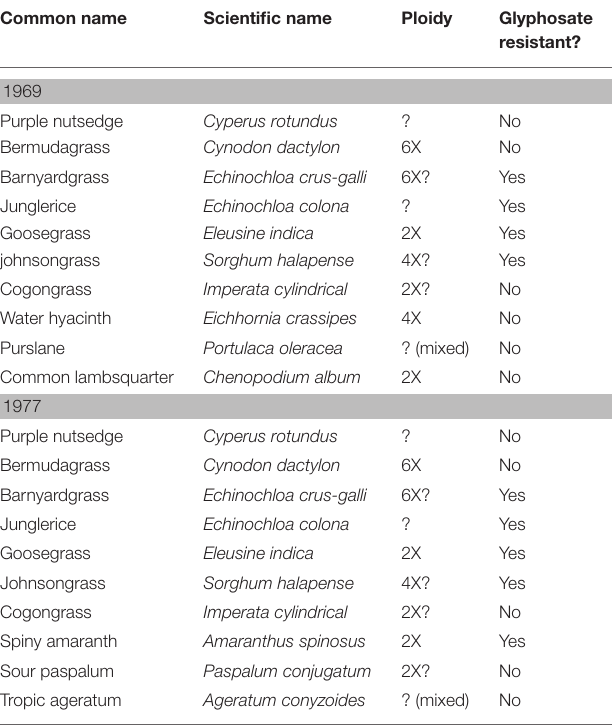
TABLE 3 | Ploidy and glyphosate resistance status of the world’s worst weeds as described by Holm and Herberger (1969), Holm et al.